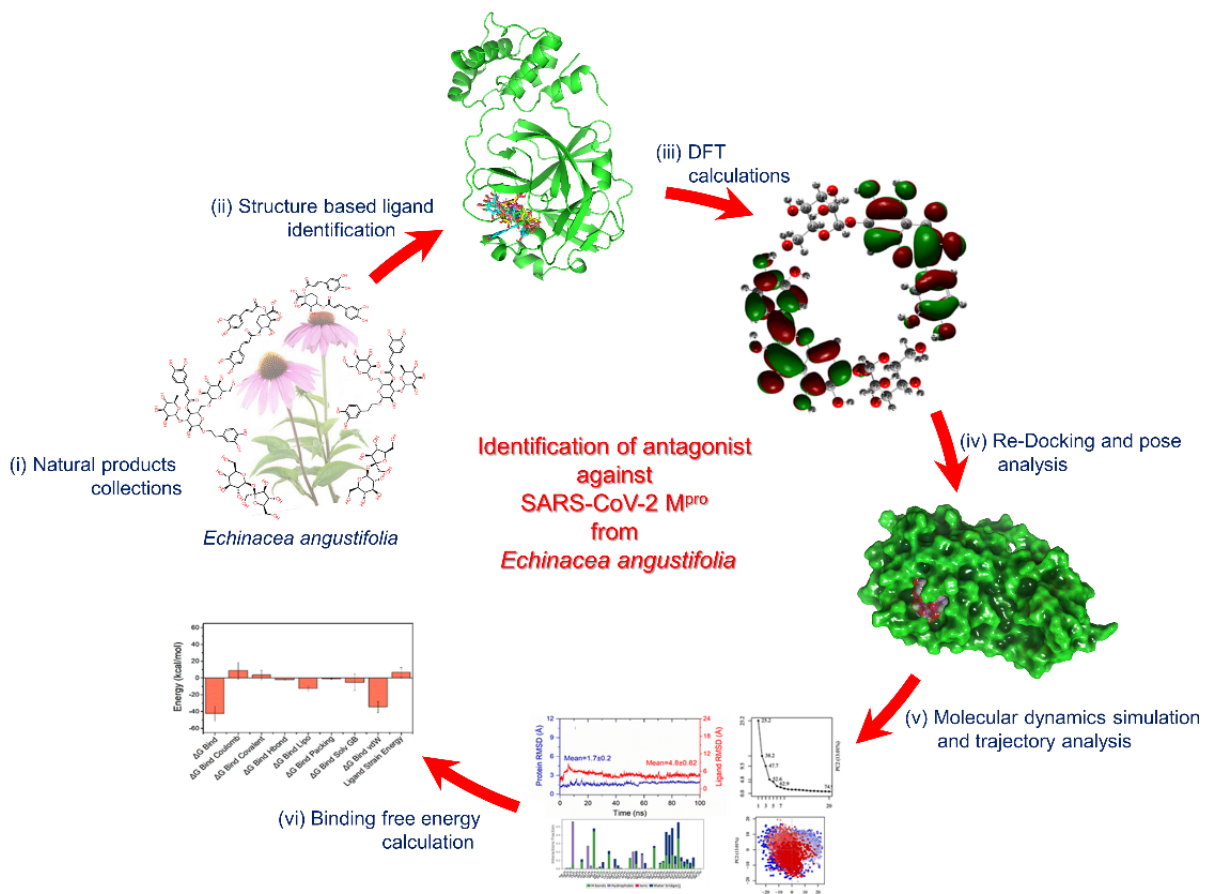
Figure 1. Computational assessment of natural products in E. angustifolia against SARS-CoV-2 M pro . Herein, ( i ) 3D structures of natural products reported in E. angustifolia were retrieved from the PubChem database, ( ii ) these natural products were then screened into the active region of SARS-CoV-2 M pro by XP docking, ( iii ) natural products with highest negative docking energy were collected and treated by DFT method for respective geometry optimization to calculate other molecular properties, ( iv ) these optimized geometries of natural products were re-docked with SARS-CoV-2 M pro and studied for pose binding and molecular contacts formation, (v) best docked poses were further studied for stability and protein ligand contact formation as function of 100 ns interval, and (vi) frames were extracted from respective MD trajectories and used in binding free energy calculations.